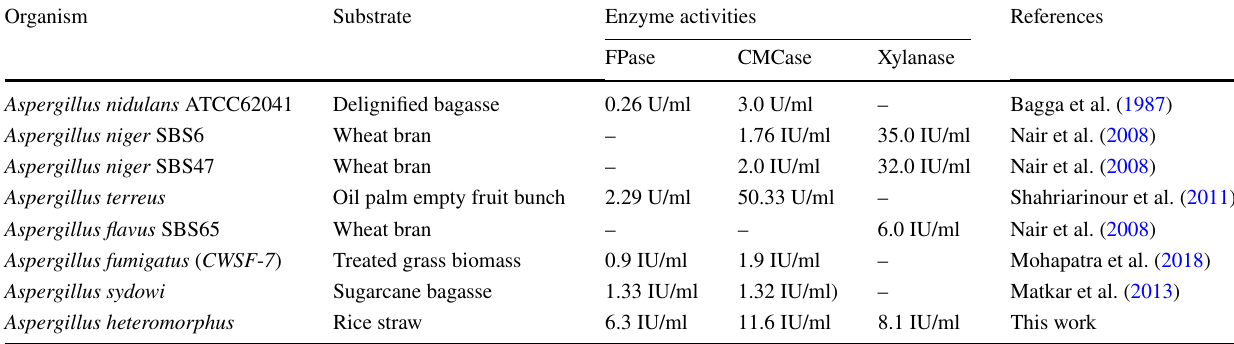
Table 3 Comparative study of enzyme activities under submerged fermentation from Aspergillus strains grown on different carbon source